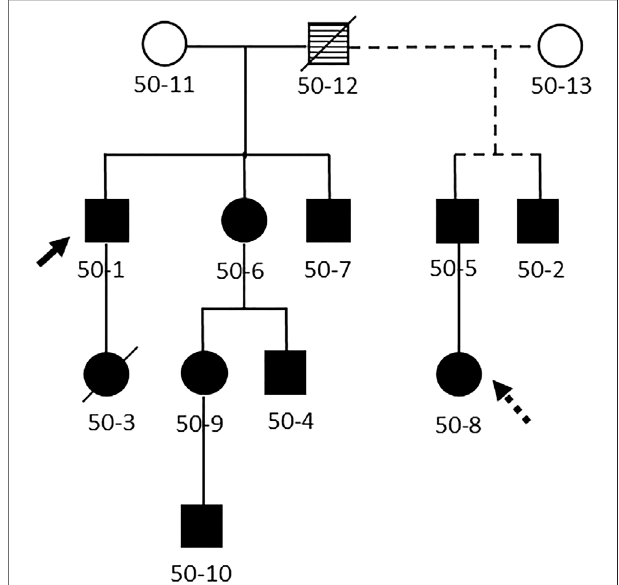
FIGURE 1 | Pedigree of the family. Legend: Abbreviated pedigree, showing only those with Diamond Blackfan anemia. Solid line, fi rst spouse; dashed line, second spouse. Filled symbol, clinically affected with DBA, open symbol, no clinical evidence for DBA, striped symbol obligate carrier. Diagonal line indicates family member is deceased. Solid arrow, proband. Dashed arrow, heterozygous mutation in RPS19 without clinical or laboratory